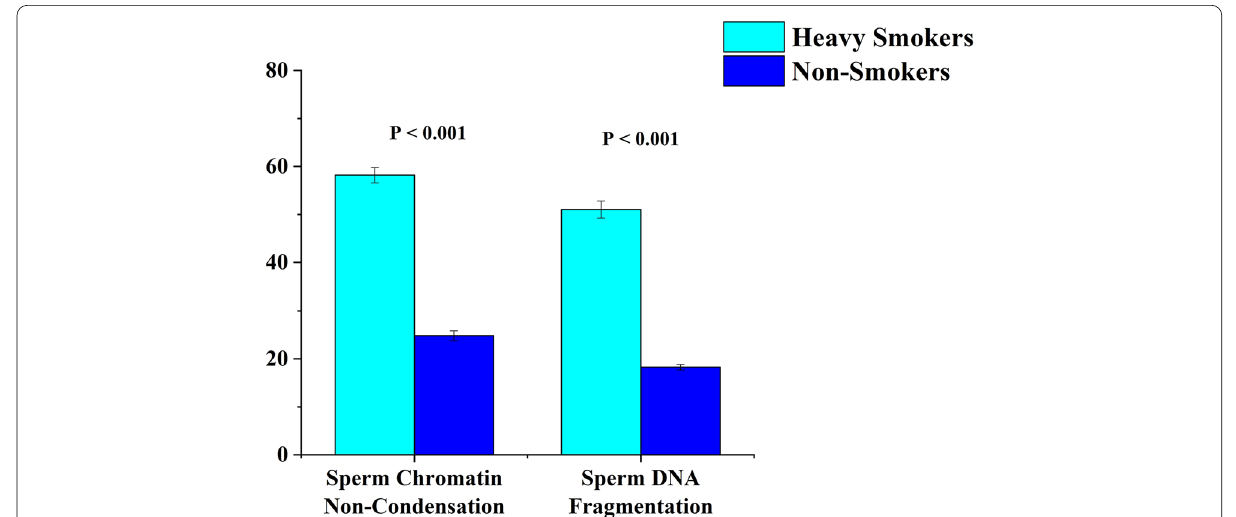
Fig. 1 Chromatin non-condensation and DNA fragmentation of spermatozoa in heavy smokers compared to non-smokers. P < 0.05: significant; P 0.05: not